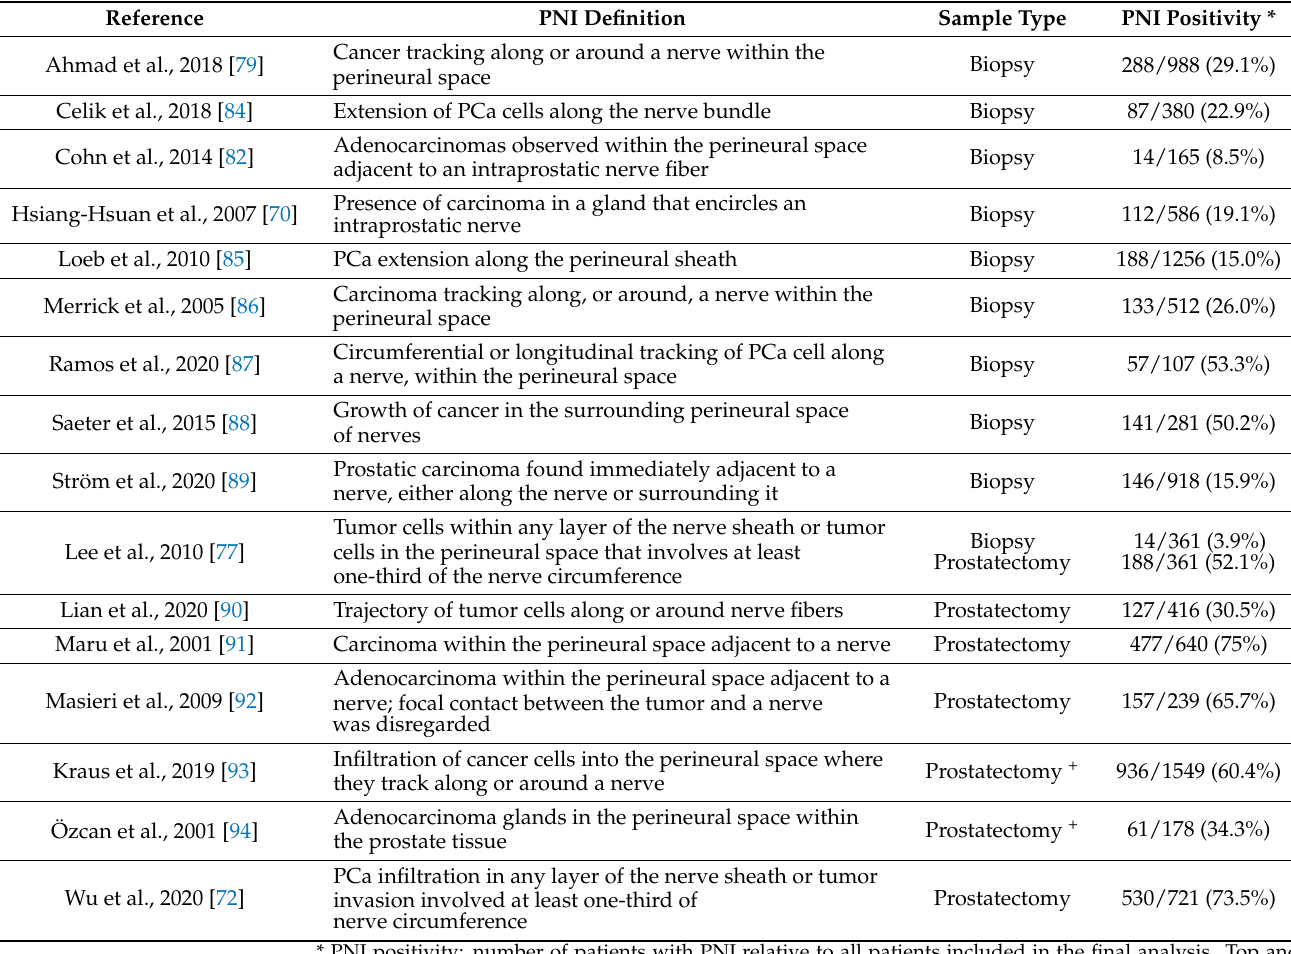
Table 1. Examples of studies using different PNI definitions and sample types and their reported PNI